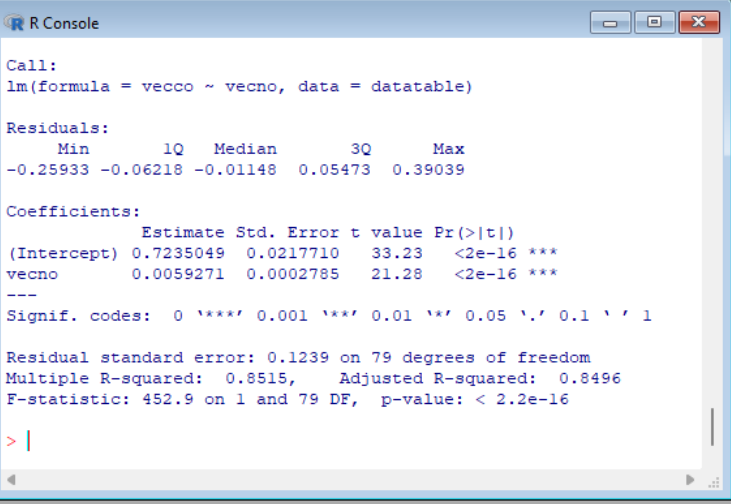
Figure 5. Example of R program execution for linear regression upon CO and NO pairs or vectors and the resulting statistics regarding mathematical model accuracy.